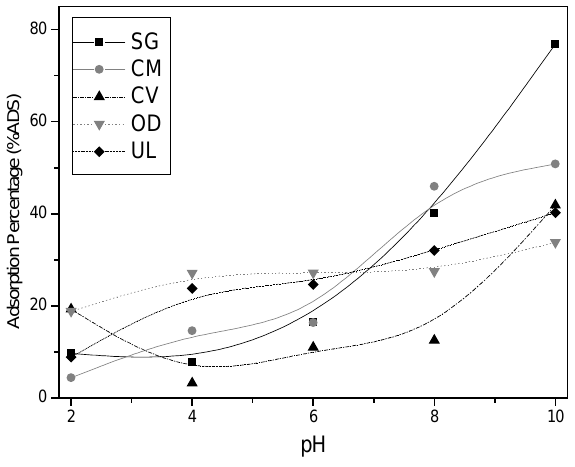
Figure 5. pH effect on the adsorption of phenol on marine algae. Mass of adsorbent: 50 mg and Phenol concentration: 50 mg/L.